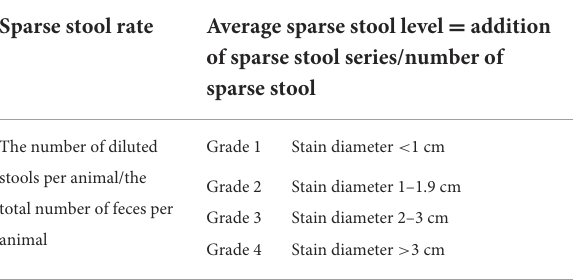
TABLE 1 Diarrhea score standard.